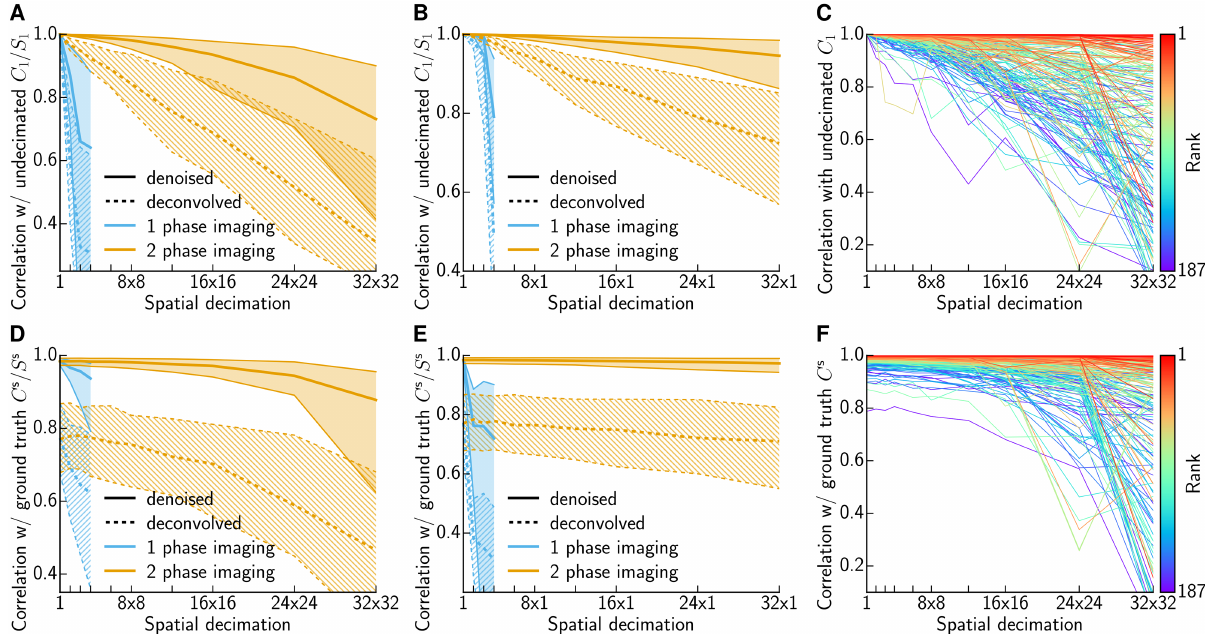
Fig 6. Quantifying the impact of decimation for 2P data. (A) Summary of correlationsbetweendenoisedtraces C 1 and C l and deconvolvedtraces S 1 and S l . Decimatingin x and y direction. Thick lines show the median,thin lines and shadedregionthe IQR. The correlationof denoised fluorescence (solid) decays slowly for 2 phaseimaging(orange)and abruptly if the shapes A l are not inferred in the pre-screening phasebut are instead estimated directly from downscaleddata (cyan). The same holds for the deconvolvedtraces (dashed). (B) Analogousto (A), but with decimationappliedjust in the spatial horizontal direction. (C) Correlation of denoisedfluorescence for each ROI plotted individually.Rank of ROI indicatedby color; better rankedROIs are less susceptible to decimationerrors. (D-F) Analogousto (A-C), but comparing to simulatedgroundtruth C s insteadof inferred C s . Traces were obtained on decimatedsimulateddata with reshuffled 1